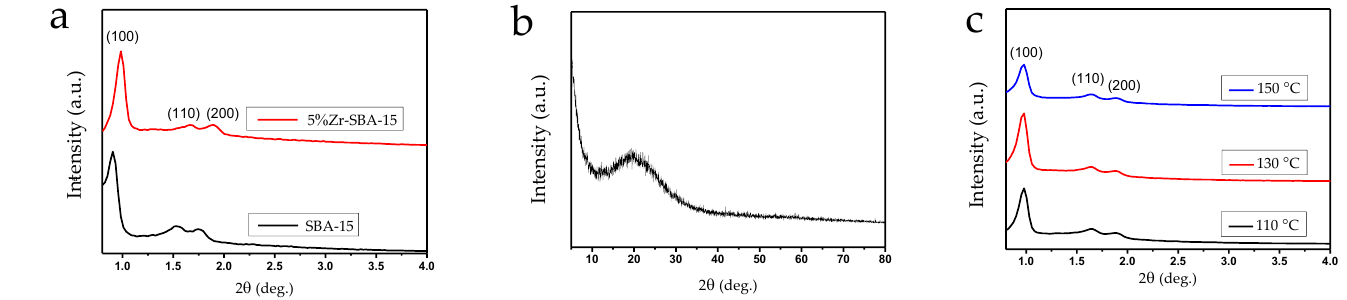
Figure 1. X-ray diffractograms: ( a ) low-angle of SBA-15, 5%Zr-SBA-15, ( b ) wide-angle of 5%Zr-SBA-15, ( c ) 5%Zr-SBA-15 after AG hydrolysis at 110 °C, 130 °C, 150 °C.